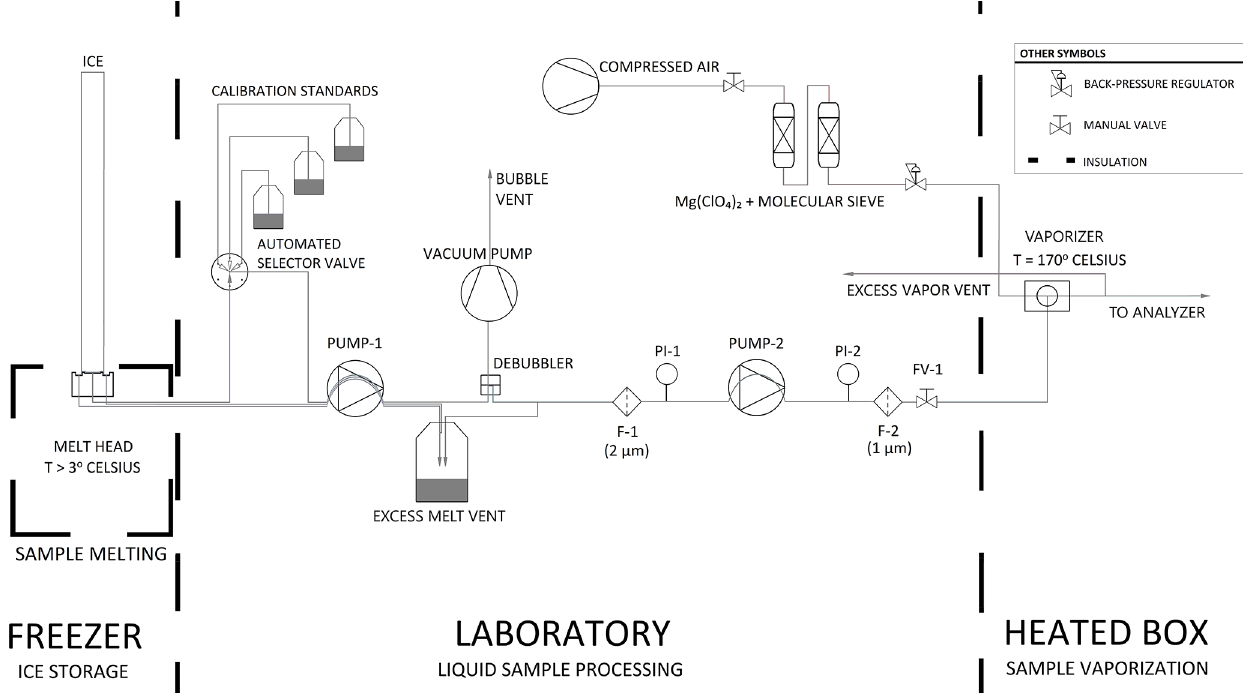
Figure 1. Process flow diagram of the CFA system. Thick dashed lines indicate transitions between temperature-controlled process spaces. Note that F-1 and F-2 are filters, PI-1 and PI-2 are pressure sensors, and FV-1 is a flow